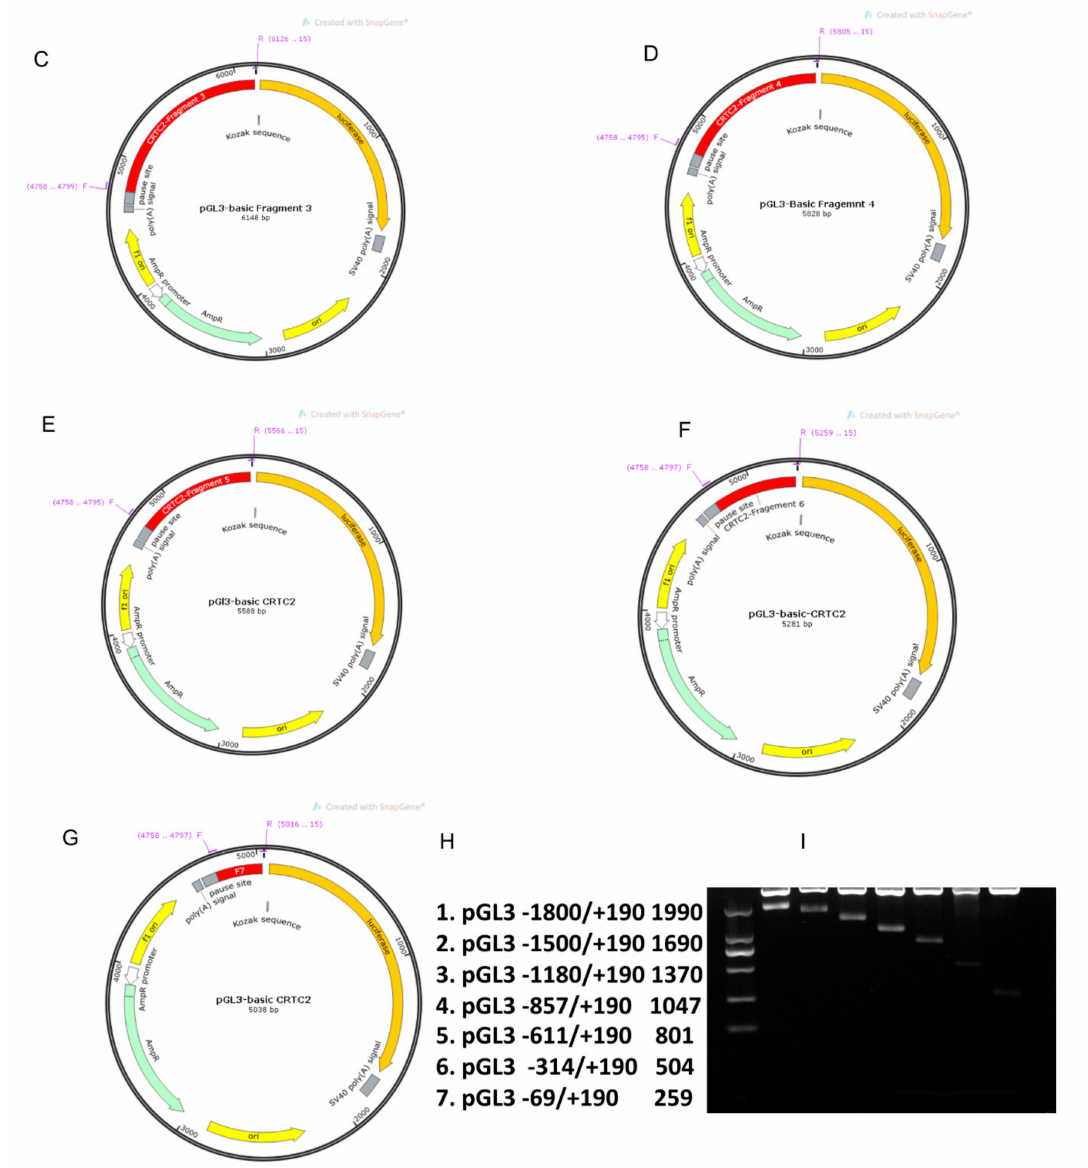
Figure 10. Amplification and cloning of TORC2 gene into pGL3-basic vector. ( A – G ) Seven di ff erent fragments of TORC2 gene have been inserted into pGL3-basic vector and presented graphically through SnapGen software. ( H , I ) Indicates amplification of TORC2 gene seven fragments ligated into pGL3-basic vector and after the enzyme cut the seven fragments, including TORC2-F1 (1990 − 1800 /+ 190), TORC2-F2 (1690 − 1500 /+ 190), TORC2-F3 (1370 − 1180 /+ 190), TORC2-F4 (1047 − 857 /+ 190), TORC2-F5 (801 − 611 /+ 190), TORC2-F6 (504 − 314 /+ 190) and TORC2-F7 (259 − 69 /+